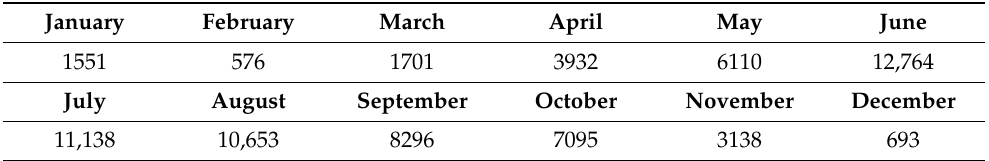
Table 8. Forecasting results for 12 periods in 2021 by Holt’s exponential smoothing method with smooth outliers and an unexpected growth factor of 1.25.